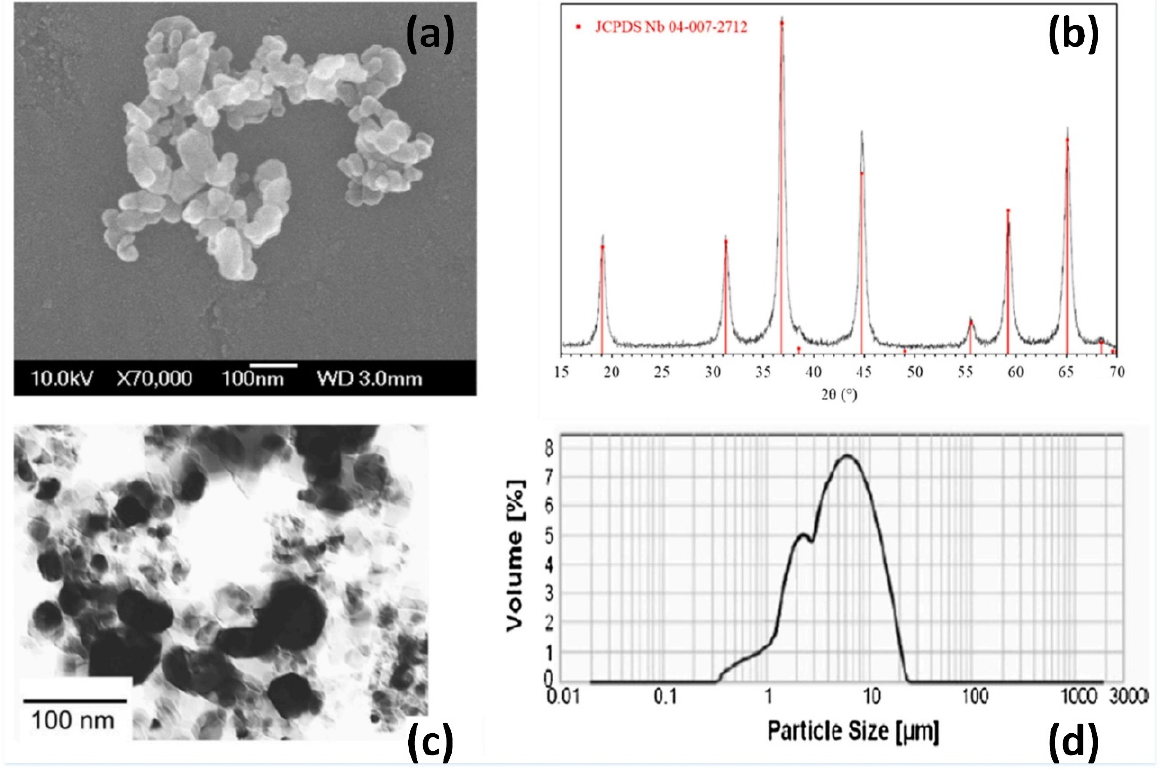
Figure 11. Sample particle size distribution and XRD pattern; ( a ) FEG-SEM micrograph, ( b ) XRD pattern, ( c ) TEM micrograph, and ( d ) particle size distribution of as-received spinel powder SPI-P1 [77]. Reprinted with permission from Ref. [77]. Copyright 2021, copyright ELSEVIER.